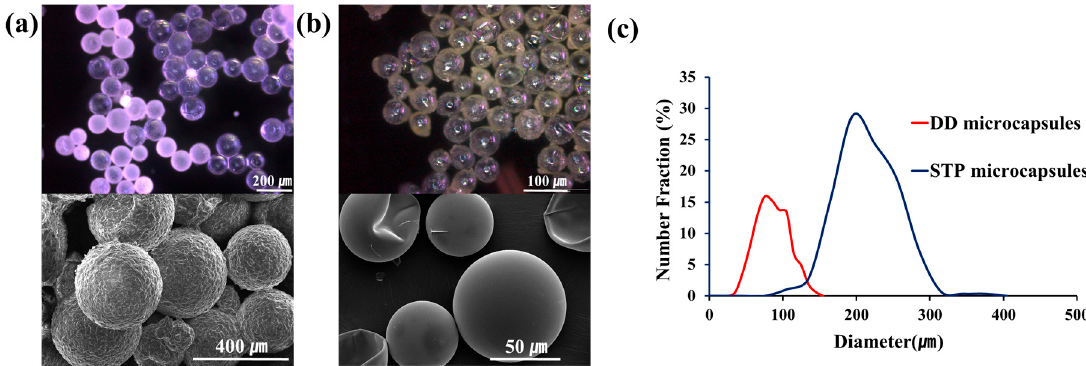
Figure 3. ( a ) Optical microscope ( top ) and SEM images ( bottom ) of the STP-containing microcapsules; ( b ) optical microscope ( top ) and SEM images ( bottom ) of the DD-containing microcapsules; ( c ) microcapsule size distribution of STP and DD microcapsules prepared at 1000 rpm.